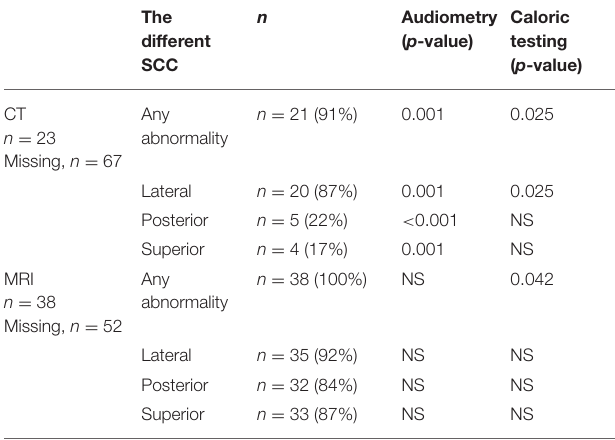
TABLE 2 | Correlation between lateral semicircular canal function loss (caloric testing) or pure tone audiometry and imaging abnormalities of the three SCC on CT and